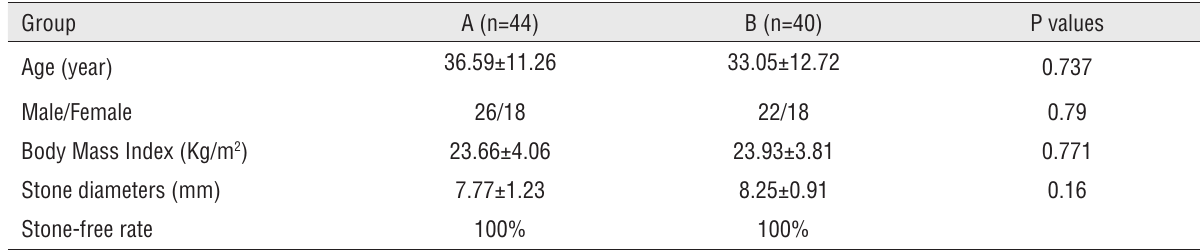
Table 1 - The demographic characteristics of patients.